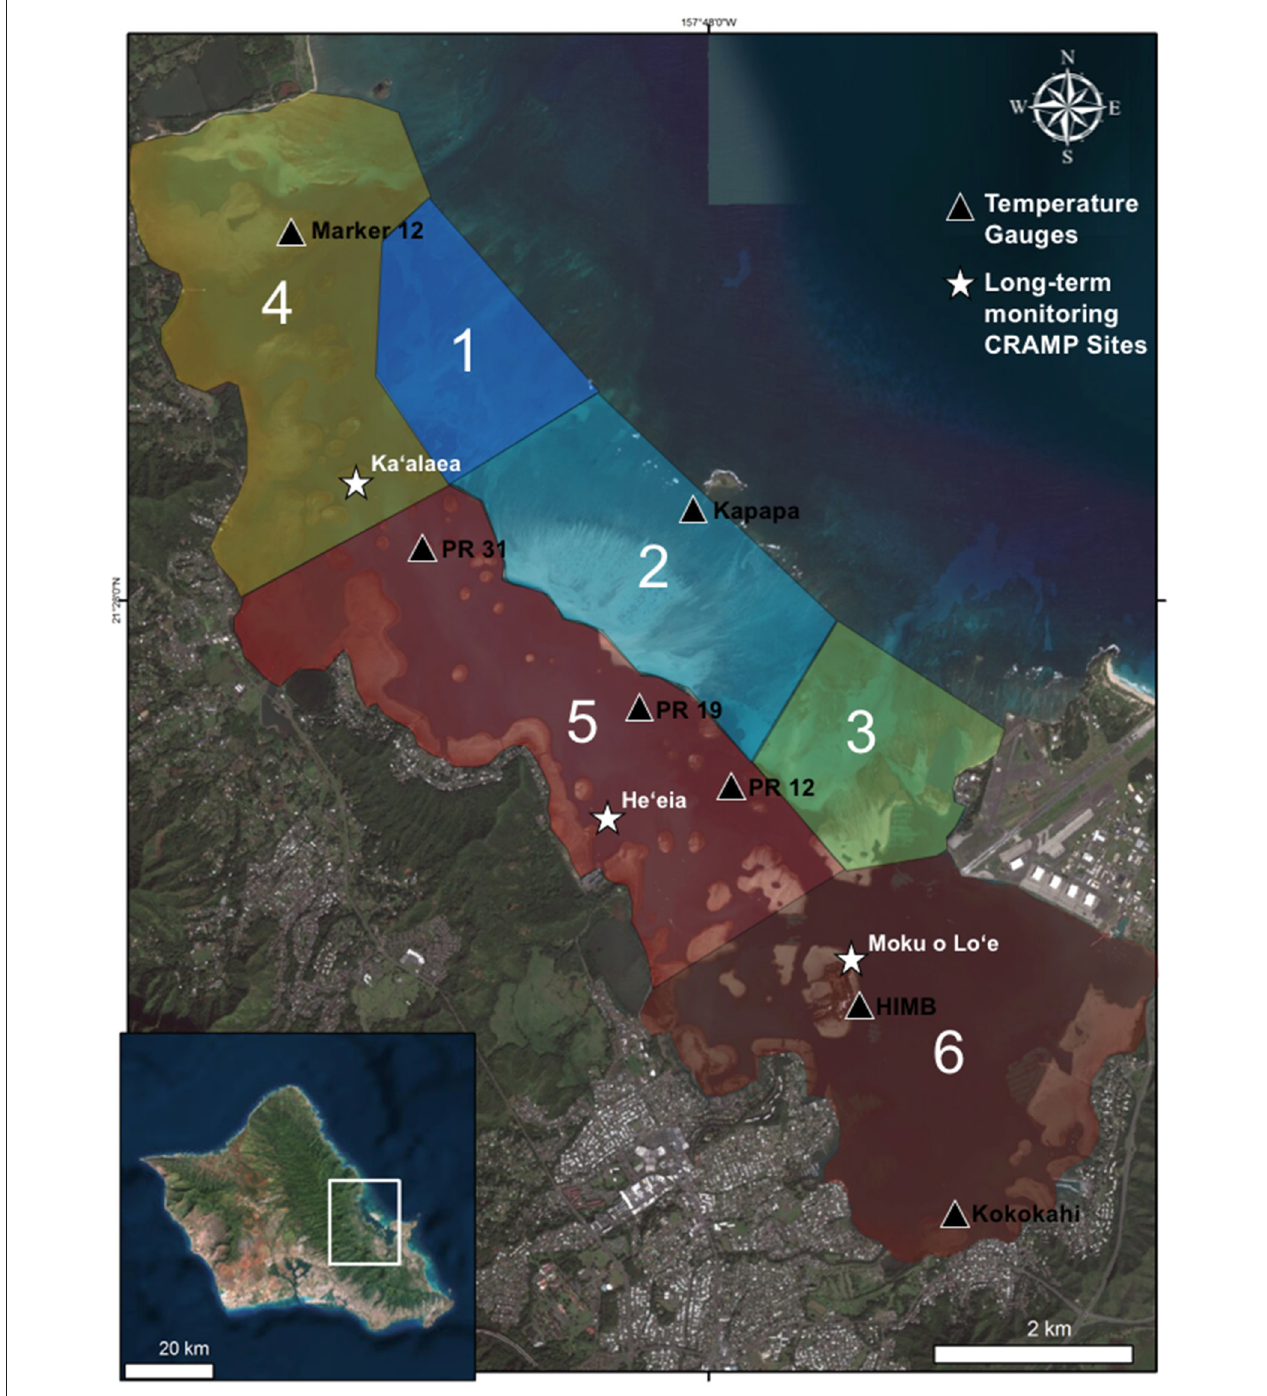
FIGURE 1 | Map of K¯ane‘ohe Bay, Hawai‘i with flow regimes (1–6) defined by Lowe et al. (2009) ( Table 1 ), in situ temperature loggers (triangles), and long-term Coral Reef Assessment and Monitoring (CRAMP) sites (stars). Photo credit: Quickbird Digital Globe.